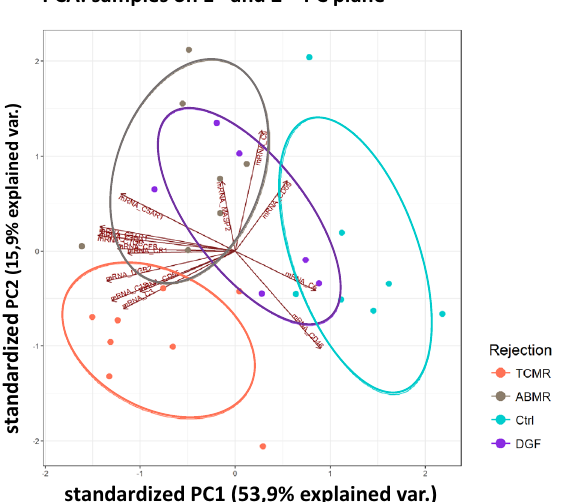
Figure 6. Principal component analysis. Biplot for the expression data of 15 selected complement genes clustered in expression profiles for follow-up biopsies of renal transplants with no rejection or dysfunction (Ctrl, n = 7), delayed graft function (DGF, n = 6), T-cell mediated rejection (TCMR, n = 8) or antibody mediated rejection (ABMR, n =